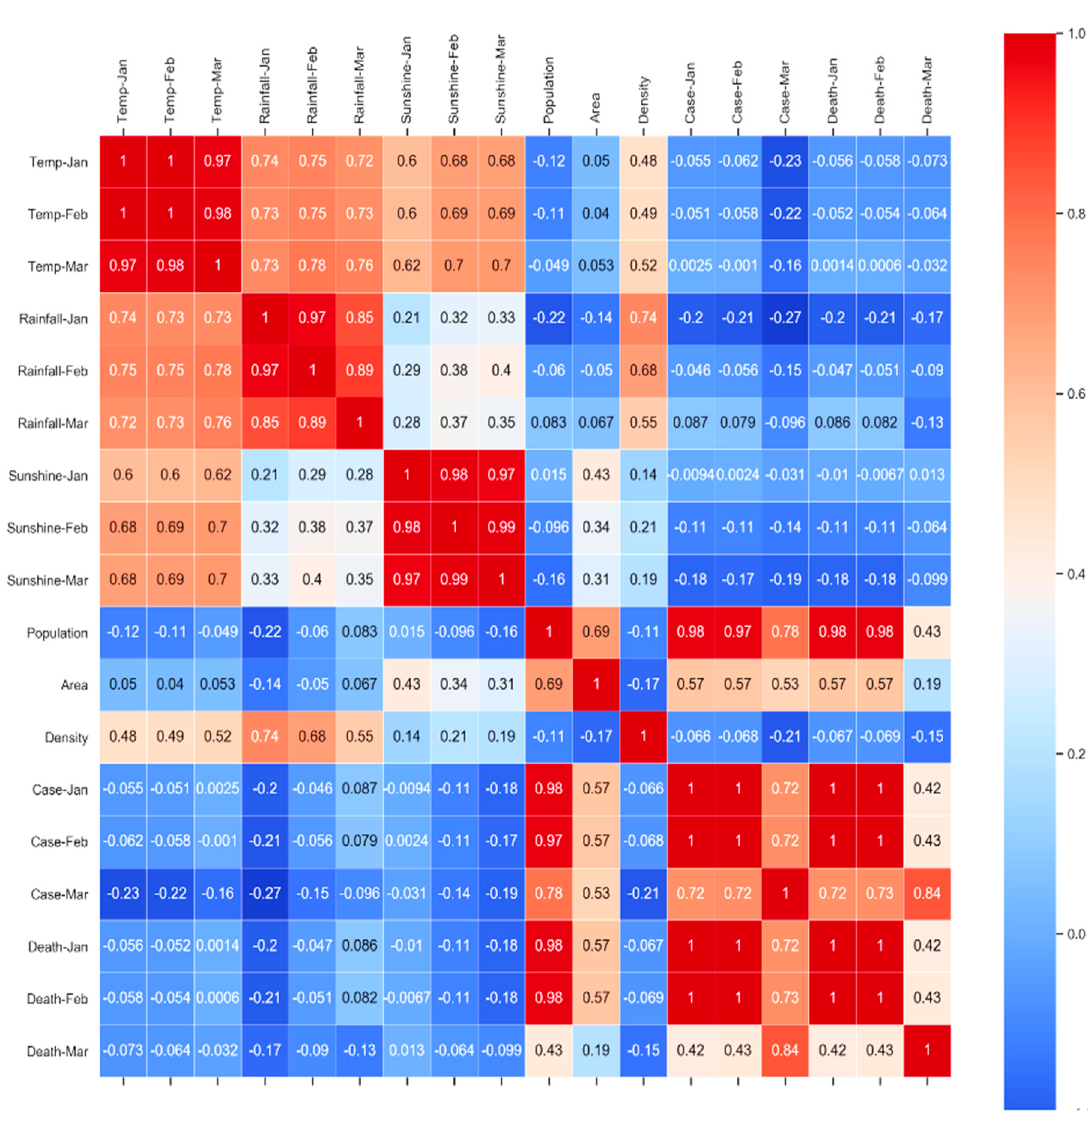
Figure 6. Correlation heatmap of simulated data (“simulated_data_1”) to check feature correlation.